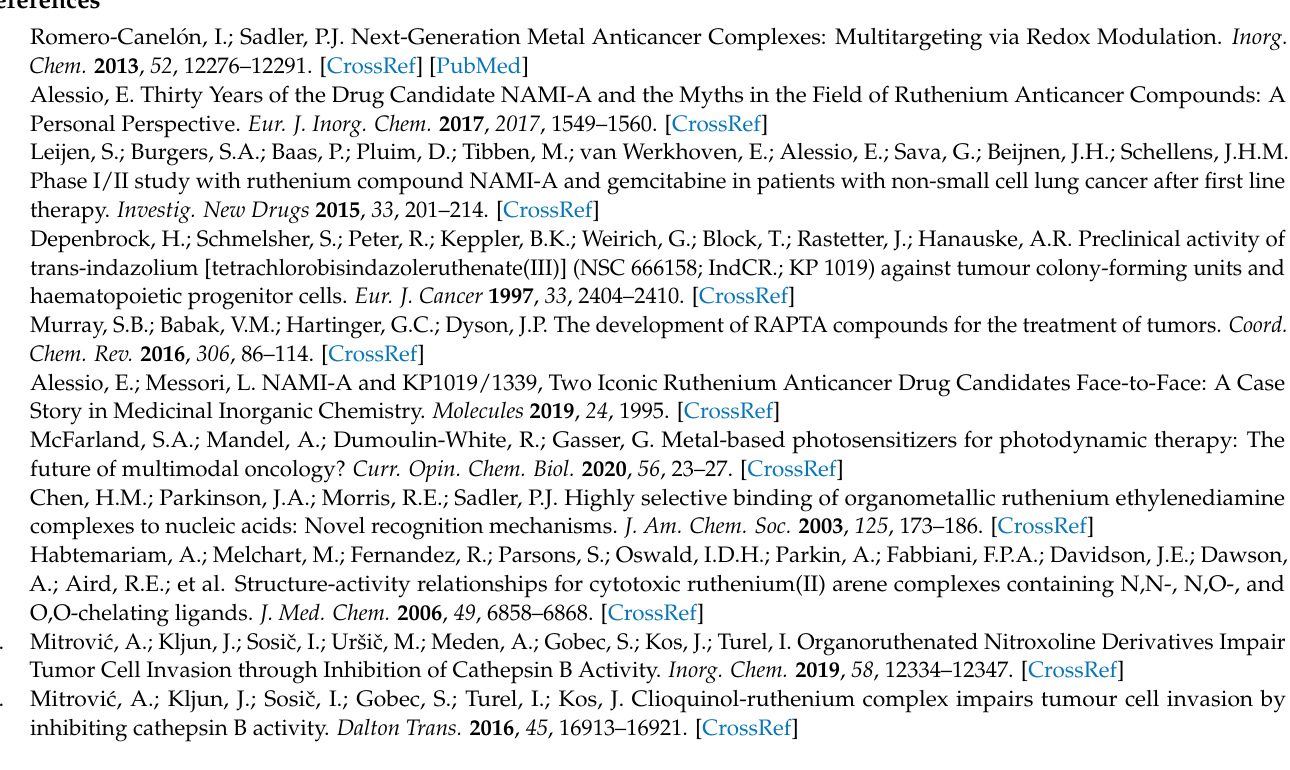
Table S1: Crystallographic data